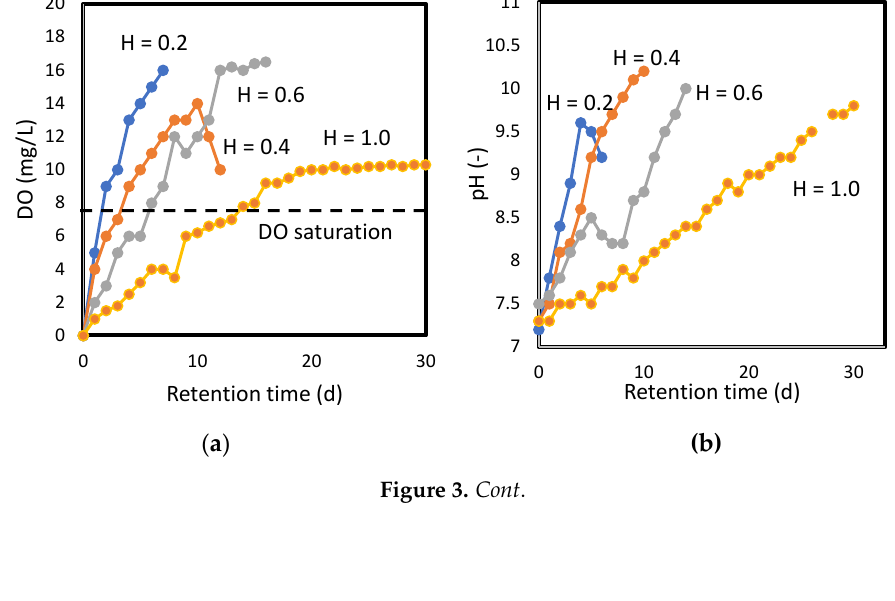
( d ) Figure 3. ( a ): Average values of DO concentrations as functions of time in SBPP with different depths H (0.2 to 1.0 m), ( b ): Average pH values as functions of time in SBPP with different depths H (0.2 to 1.0 m), ( c ): Average values of ammonium concentrations as functions of time in SBPP with different depths H (0.2 to 1.0 m), ( d ): Average values of phosphate concentrations as func- tions of time in SBPP with different depths H (0.2 to 1.0 m). It is important to note that the profiles of Figure 3 are all influenced by the climate so that under different circumstances the result will be different. Ideally for any particular project an experimental investigation should be carried out. With the aid of the data in Figure 3, models were developed that could foresee the values of pH, nitrogen and phosphorus in time. The following sections show the deriva- tion of these models. 3.2. Model for pH Variation and Nitrogen Removal in Sequential Batch Polishing Ponds In the previous section, the magnitude of the pH variation was determined as a result of changes in alkalinity and acidity. In order to know the time required for a particular pH variation, it is necessary to take into account the kinetics of the relevant processes. The desorption/absorption processes can be described in terms of Fick’s law, which says that the rate of a process is proportional to the inductive force of that process (Morais et al. [19]). In the case of volatile components (CO 2 and NH 3 ) the inductive force is the difference between the saturation concentration and the actual concentration, so that: For CO 2 desorption